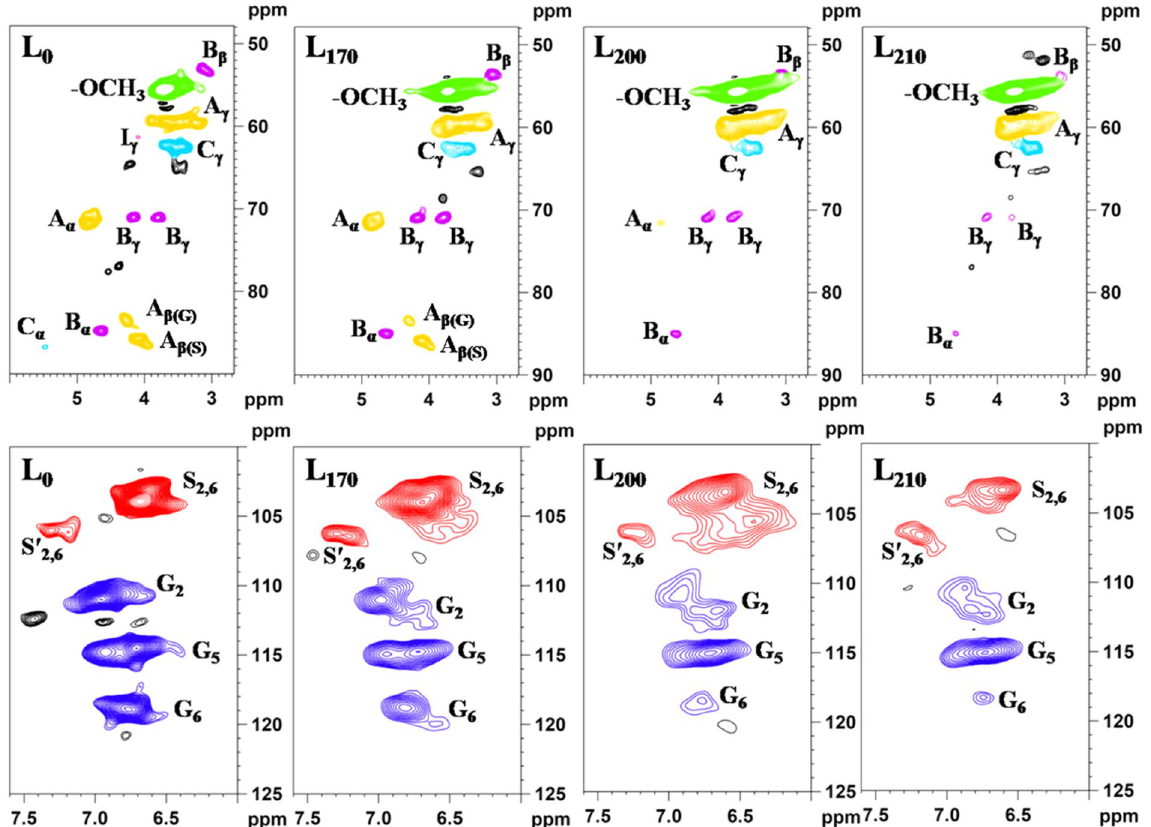
Figure 1. 2D-HSQC spectra of the lignin fractions (L 0 , L 170 , L 200 , and L 210 ) extracted from Eucalyptus .